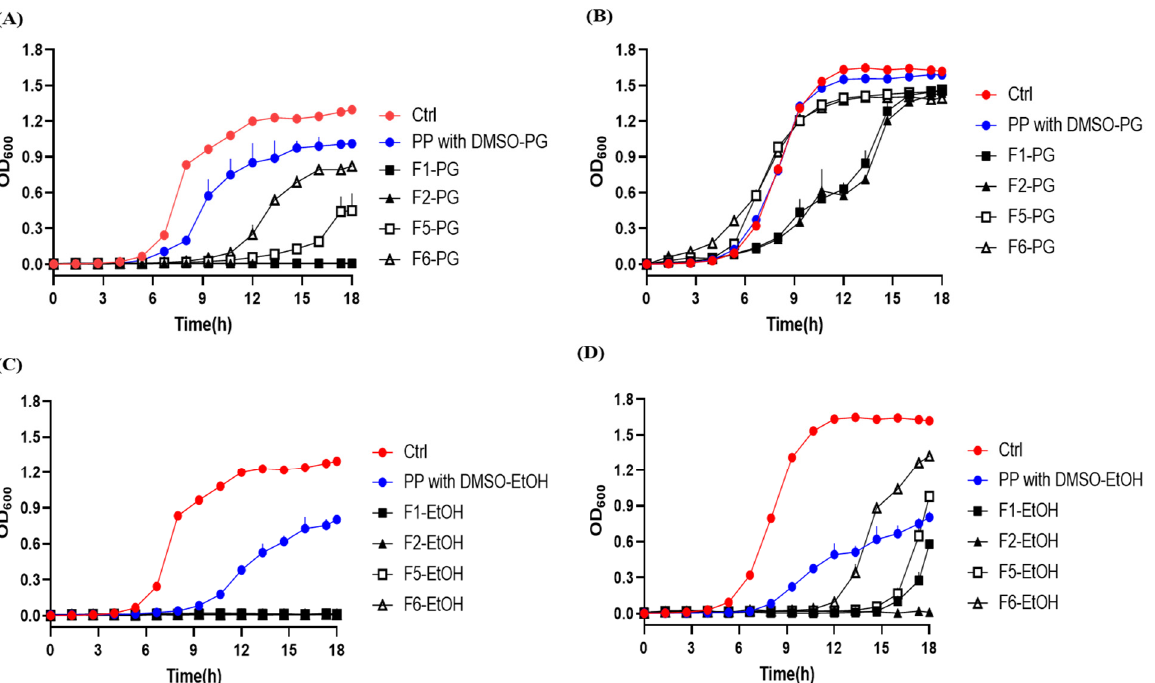
Figure 8. Time-kill kinetics of S. aureus ( A , C ), C. albicans ( B , D ) incubated with formulations of propolis extract in propylene glycol (F1-PG, F2-PG, F5-PG, and F6-PG) ( A , B ), in ethanol extract (F1-EtOH, F2-EtOH, F5-EtOH, and F6-EtOH) ( C , D ). Data are expressed as mean ± S.D. ( n = 3).